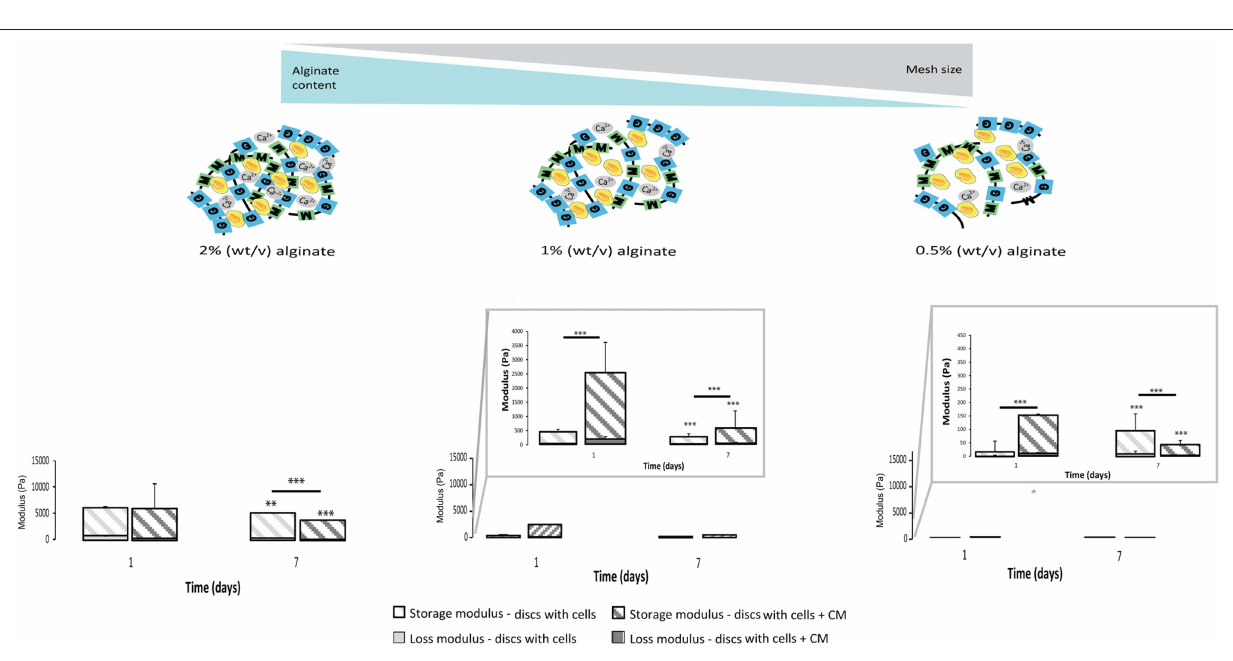
FIGURE 5 | Physical properties of the 3D alginate discs. Rheological properties of the 3D alginate discs incubated with culture medium or with astrocytes in the presence or absence of CM ( n = 3 ). Results are shown as mean ± standard deviation; asterisks represent statistical differences,), regarding statistical analysis asterisks alone represent differences between storage modulus, asterisks above the bars with guidance line represent differences between total levels, ** p < 0.01 , *** p < 0.001